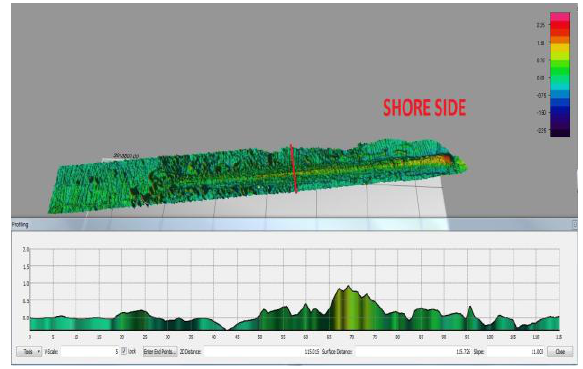
Figure 16: Change detection profile of the middle of the channel .